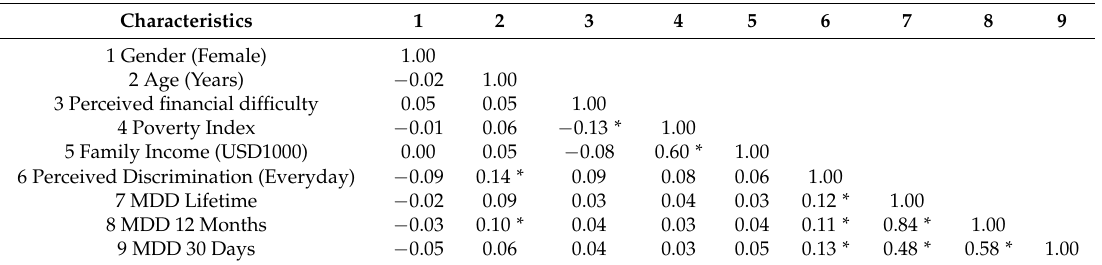
Table 2. Correlation matrix ( n =